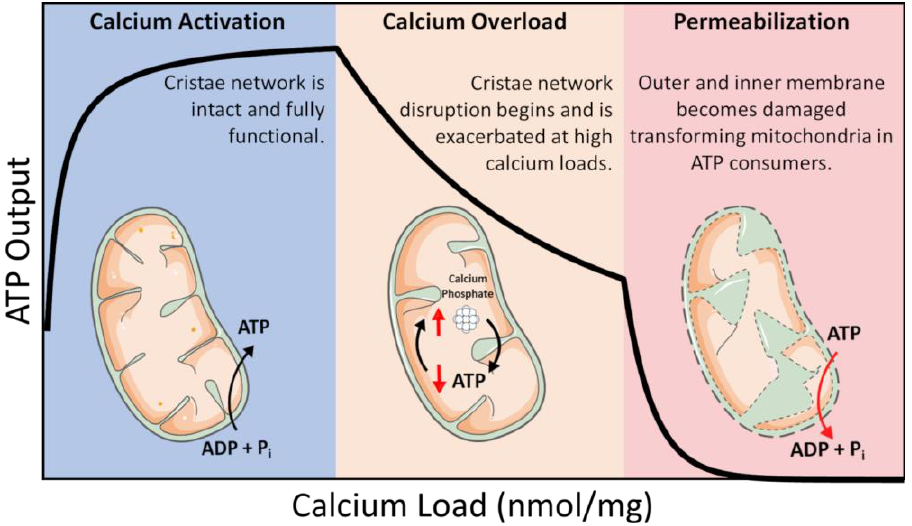
Figure 1. Calcium overload. In low amounts, calcium enhances mitochondrial function by activating several Ca 2+ – sensitive catabolic enzymes. In moderate amounts, depressed rates of oxidative phos- phorylation become observable. In extreme amounts, mitochondria become structurally compromised and consume ATP in a futile attempt to restore homeostasis.